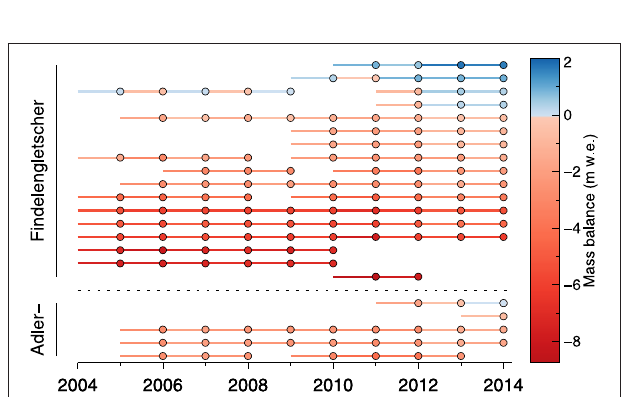
FIGURE 2 | Readings (dots) and measurement periods (lines) of the annual point balance measurements on Findelengletscher and Adlergletscher sorted by elevation such that highest elevation is at the top of the